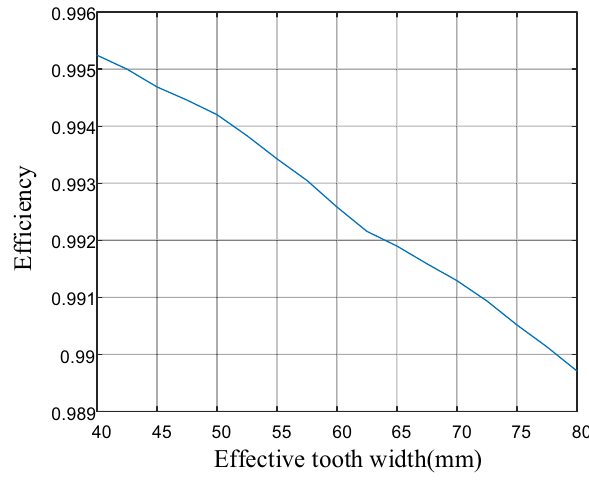
Fig. 13 Influence of effective tooth width on transmission effi- ciency